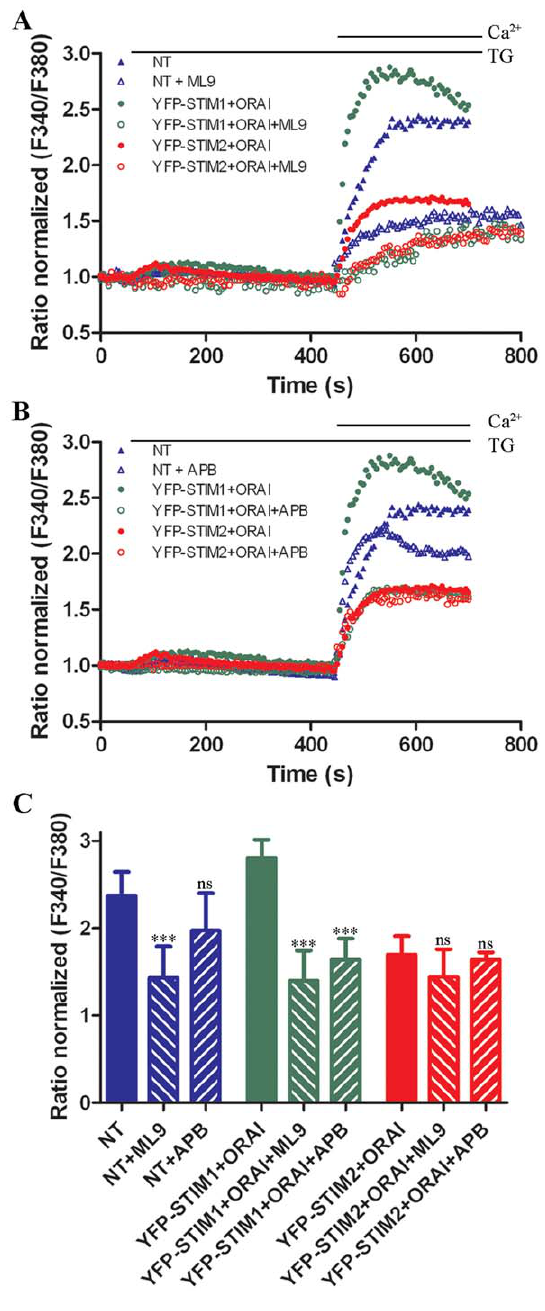
Figure 5. Effect of SOCE inhibitors ML9 and 2-APB on TG- sensitive SOCE in transfected cortical neurons. ( A–B ) Cortical neurons were co-transfected with YFP-STIM1 and ORAI1 or YFP-STIM2 and ORAI1 or nontransfected (NT). Experiments were performed as described in Figure 4, but ( A ) 100 m M ML9 or ( B ) 50 m M 2-APB was added before store depletion with TG in the presence of inhibitors. Ca 2 + (2 mM) was then added to assess SOCE. Each trace represents the average response of cells measured on a single coverslip from three independent experiments. F 340 /F 380 values beginning just before the addition of TG were normalized to the same values (1). ( C ) The average increase in Ca 2 + entry observed after the addition of 2 mM CaCl 2 to transfected or nontransfected cells in the absence or presence of the SOCE inhibitors from experiments performed as described in ( A–B ). The data show the peak of the F 340 /F 380 ratio after extracellular Ca 2 + was added. *** p , 0.001; ns, not significant (ANOVA). Error bars represent the standard error from three independent